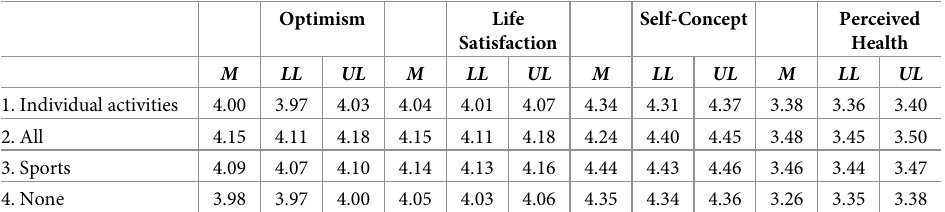
Table 4. Results of ANCOVA with latent class membership predicting well-being, adjusted for gender and home language. Optimism Life